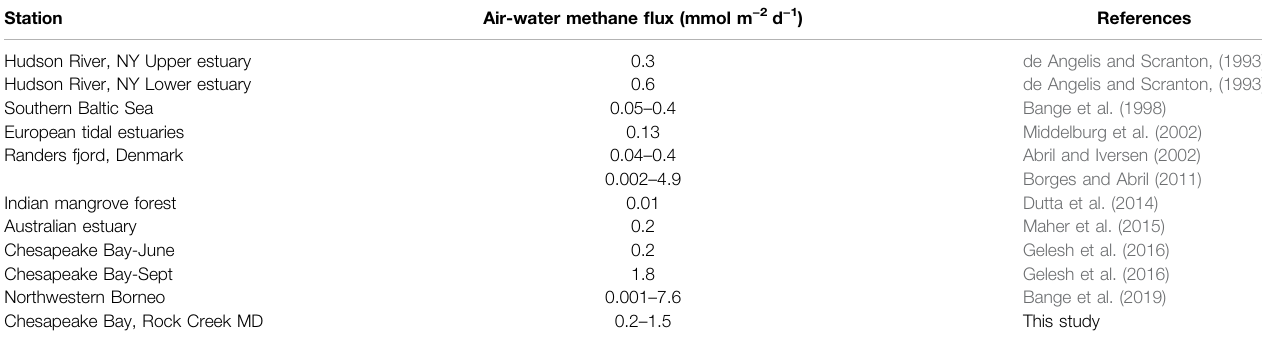
TABLE 3 | Examples of estuarine fl ux of methane to the atmosphere.